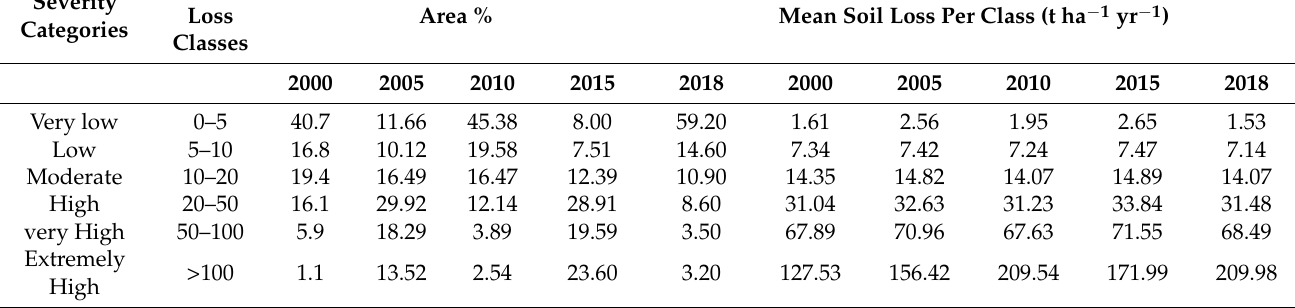
Table 4. The rates of estimated soil loss per class (of entire erosive lands of 4,670.8 km 2 ) corresponding to Figure 9.